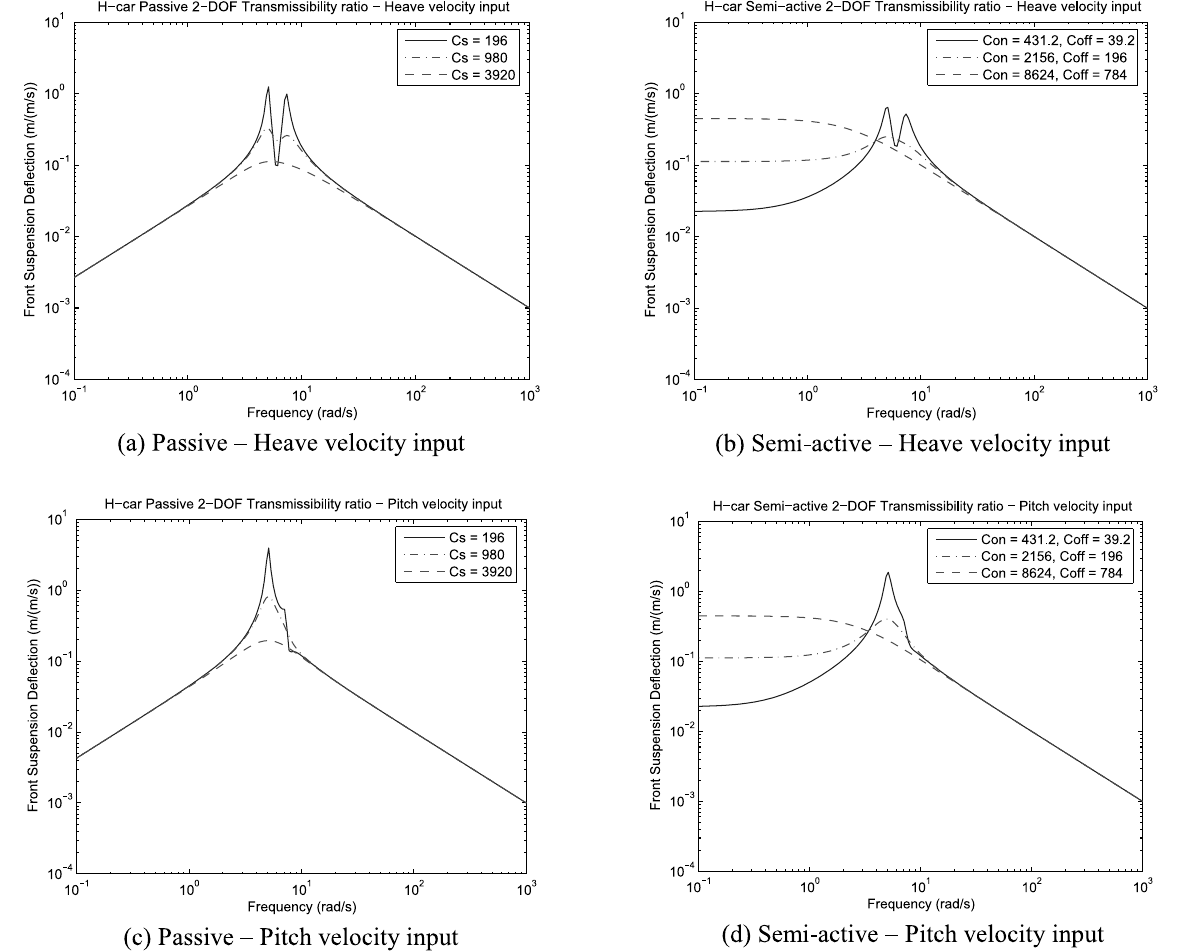
Fig. 5. Transmissibility ratio of front suspension deflection for various damping